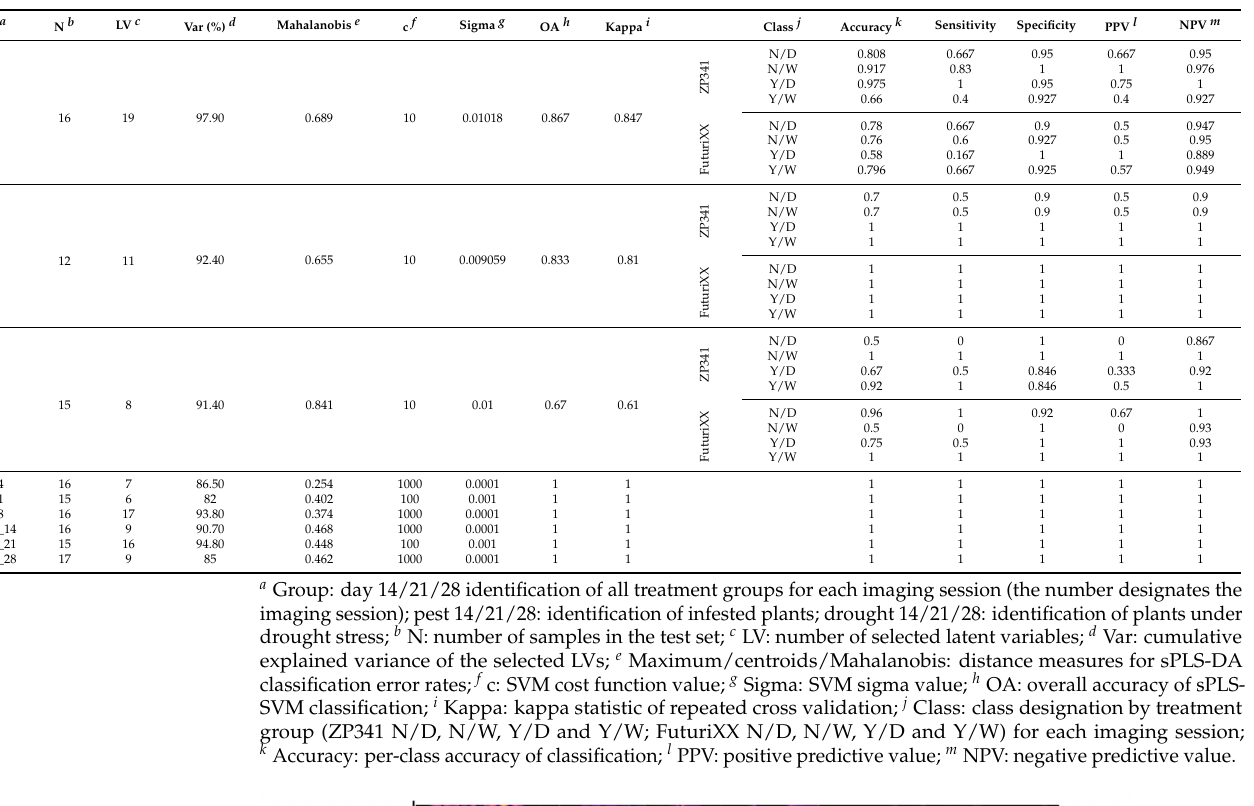
Table 5. sPLS-SVM classification results of each imaging session. Treatment labels are defined in Table 1.